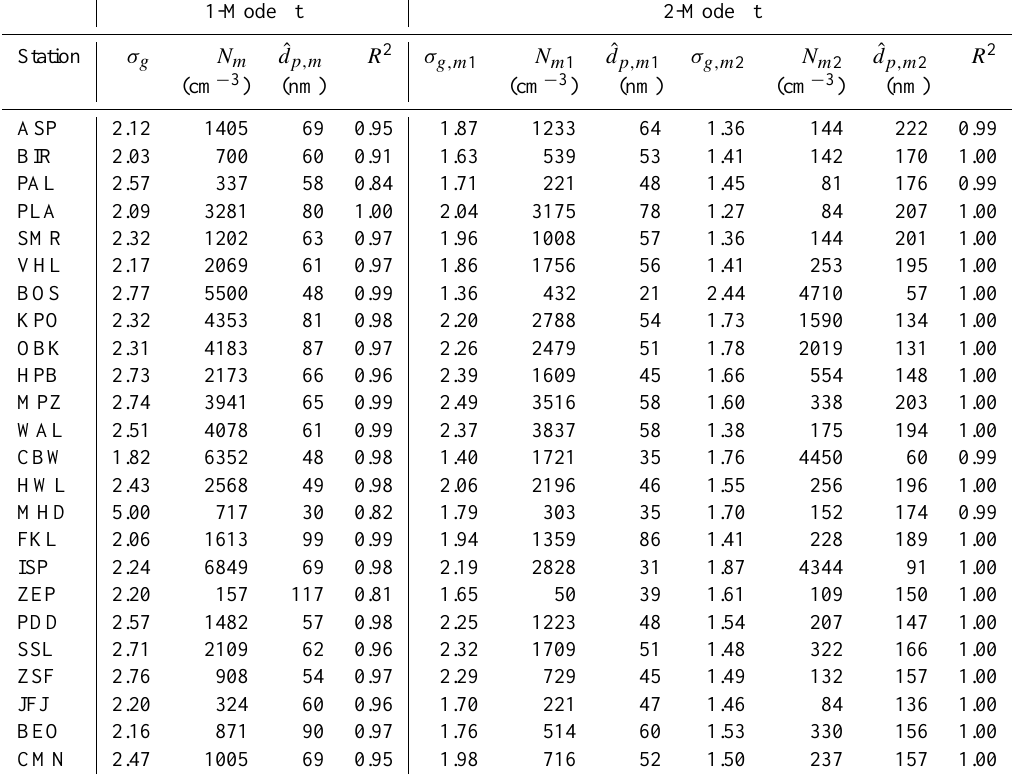
Table 6. Modal fit parameters for median size distributions in the stations. σ g is the geometric standard deviation of the mode, N m is the mode number concentration, ˆ d p,m is the geometric mean dry diameter of the mode and R 2 is the coefficient of determination between observed and fitted size